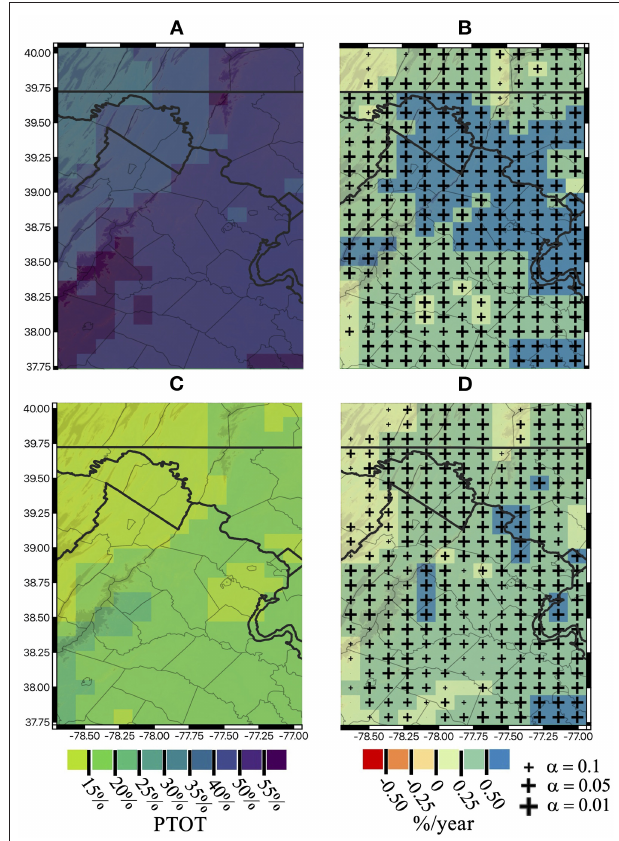
FIGURE 8 | Average percentage contribution of the top 5% [R95pTOT; (A) ] and the top 1% [R99pTOT; (C) ] to the total wet day precipitation derived at each grid point. Theil-Send trend magnitudes are presented for R95pTOT (B) and R99pTOT (D) during 1980–2018. Results from the Mann-Kendall test at 0.01 (large crosses), 0.05 (medium crosses), and 0.10 (small cross) significance levels are